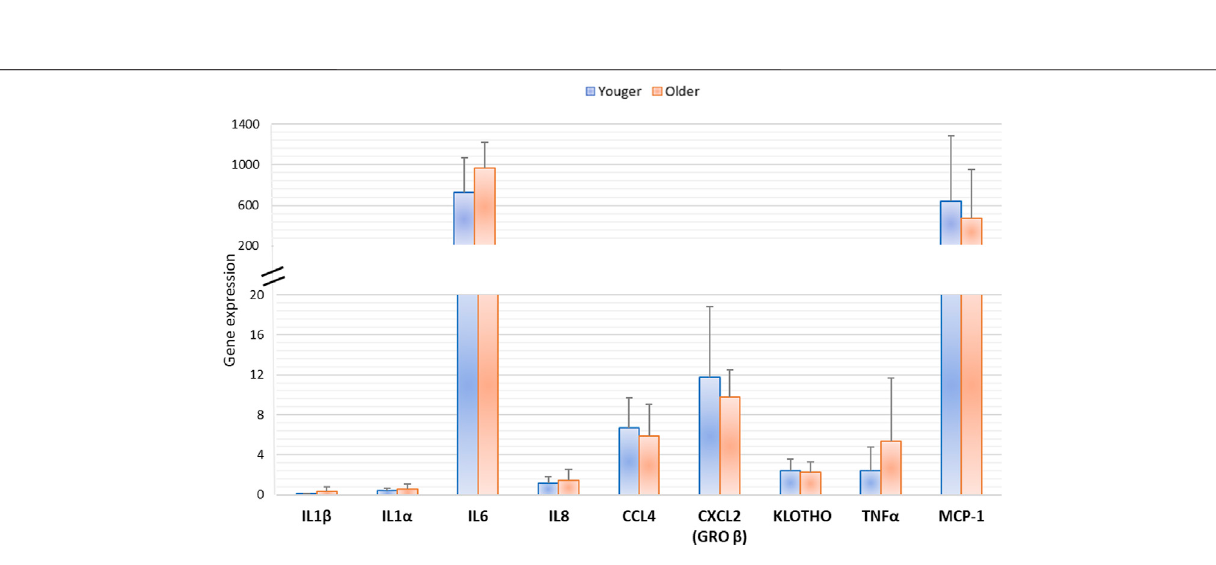
Frontiers in Bioengineering and Biotechnology |